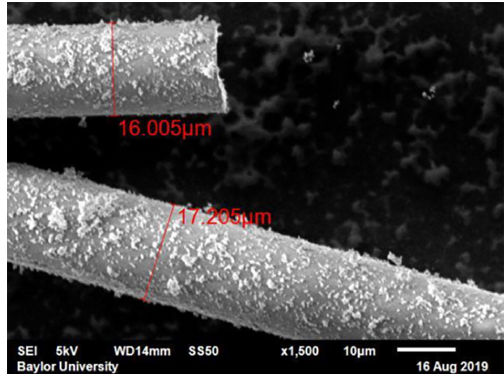
Figure 6. Example of diameter measurements taken from a Scanning Electron